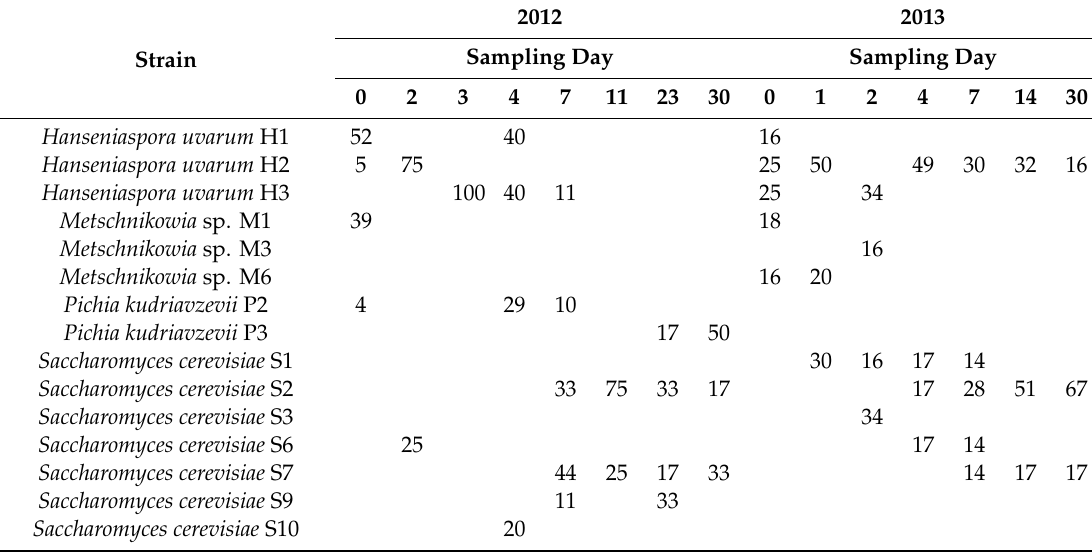
Table 4. Yeast strains (%) isolated from di ff erent stages of Stanley plum mash fermentation (2012 and 2013 seasons).